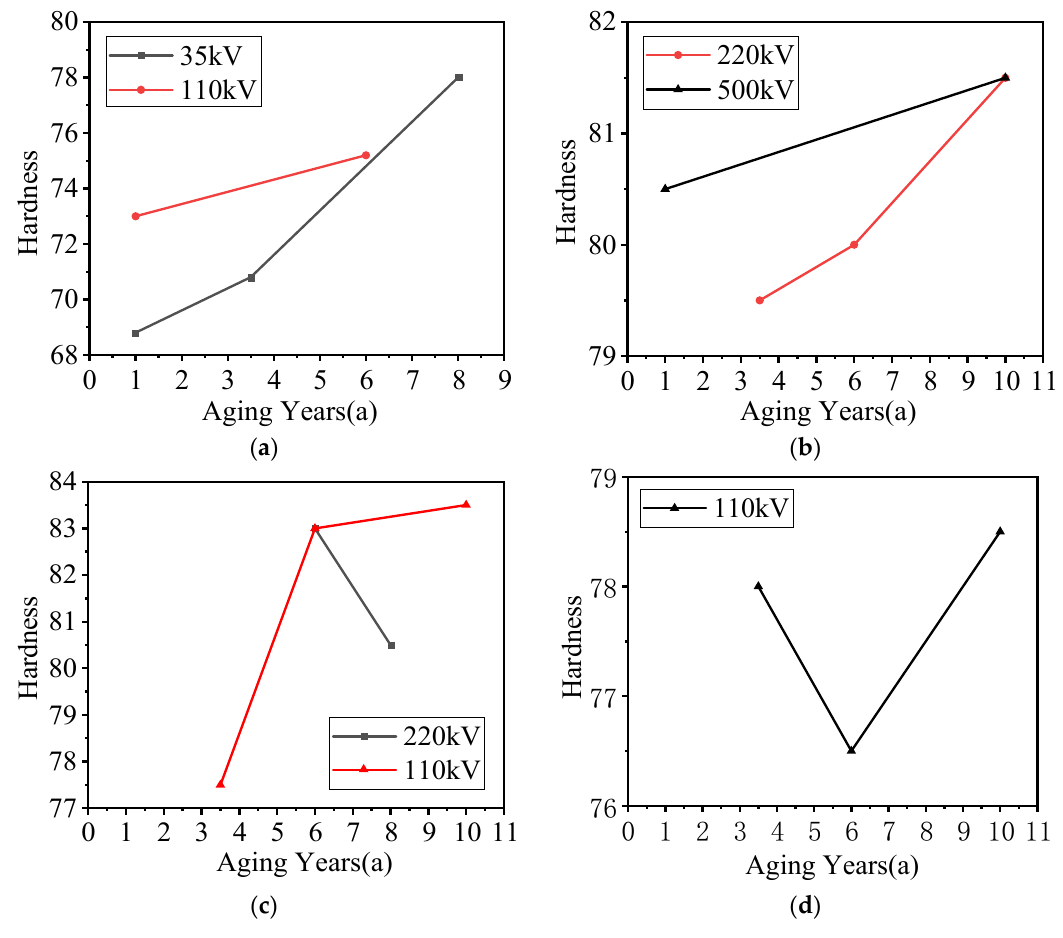
Figure 9. Variation of samples’ hardness with years of aging: ( a ) Factory A, ( b ) factory B, ( c ) factory C, ( d ) factory D.